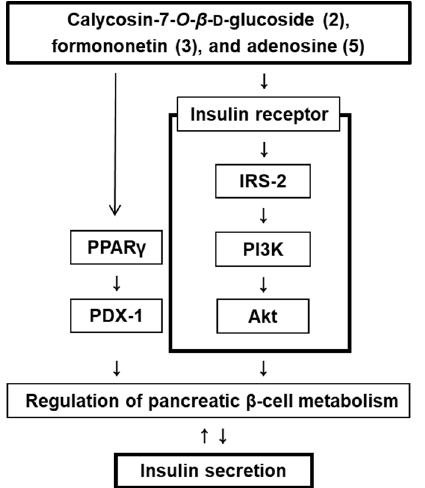
Figure 5. Schematic illustration of the effects of compounds 2 , 3 , and 5 isolated from A. membranaceus on the protein expression levels of peroxisome proliferator-activated receptor- γ (PPAR- γ ), pancreatic and duodenal homeobox-1 (PDX-1), insulin receptor substrate-2 (IRS-2), phosphatidylinositol 3-kinase (PI3K), P-Akt (Ser473), and Akt in INS-1 cells.